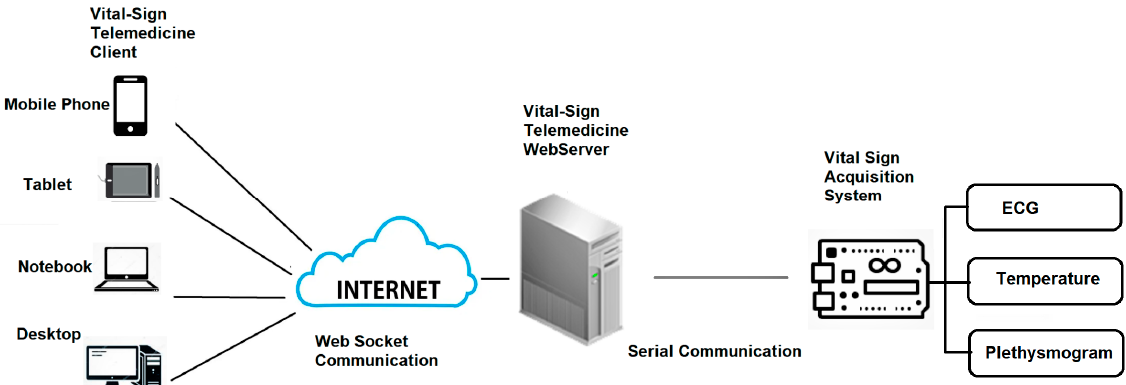
Figure 6. Vital-sign telemedicine system.